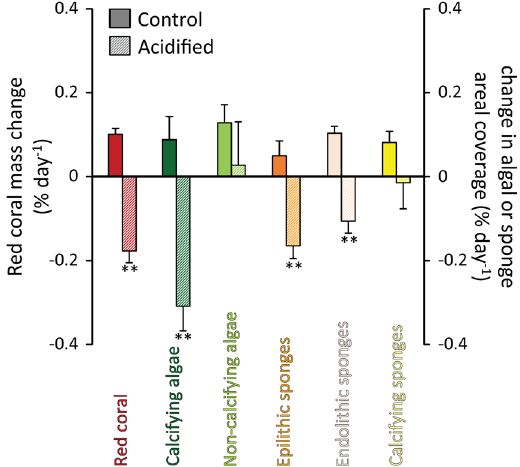
Figure 1. Impact of acidification on the dominant taxa. Reported are the changes in the growth rates of different coralligenous taxa due to the acidification treatment. The growth rates are expressed as shifts in mass weight for the red coral or in areal coverage for macroalgae and sponges. Reported are average values and SDs. Asterisks indicate significant differences ( ** p < 0.01) in the acidified treatment compared with the respective